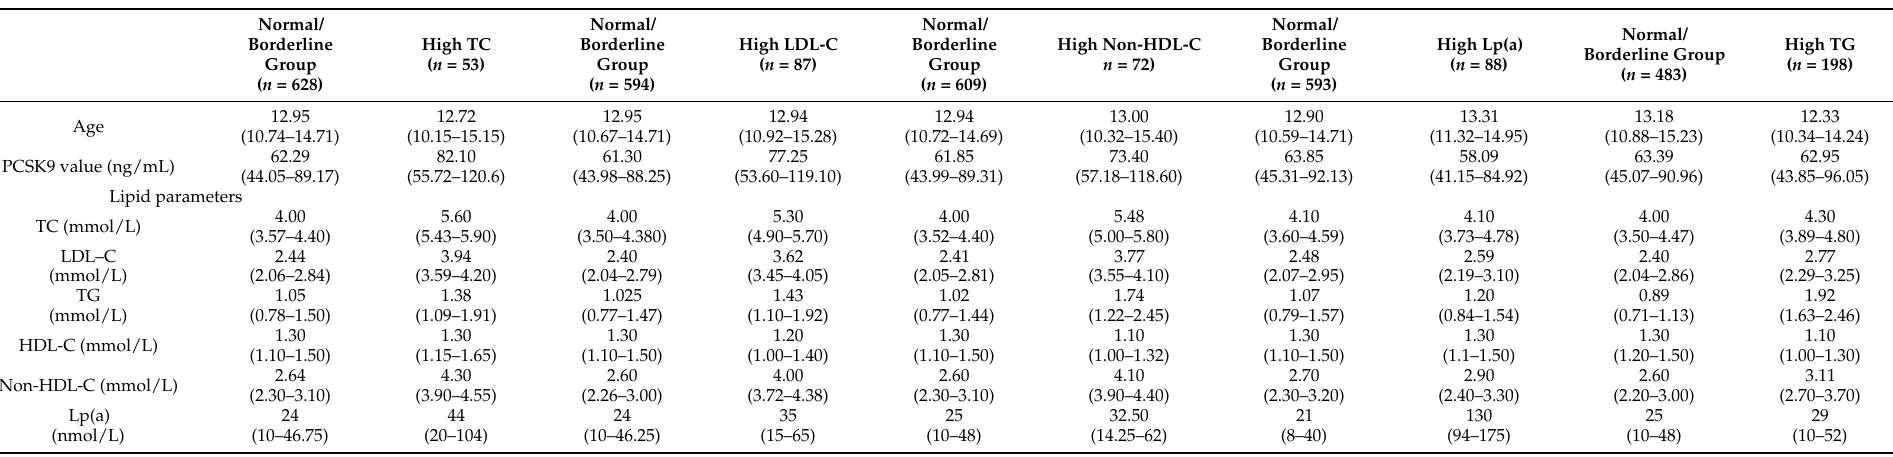
Table 3. Baseline demographic, PCSK9 values, and lipid parameters of the five subgroups (high TC, high LDL-C, high Non-HDL-C, high Lp(a), high TG) when taken independently. Categorical variables are expressed as percentages and non-normal continuous variables are expressed as median with its interquartile ranges (1st quartile–3rd